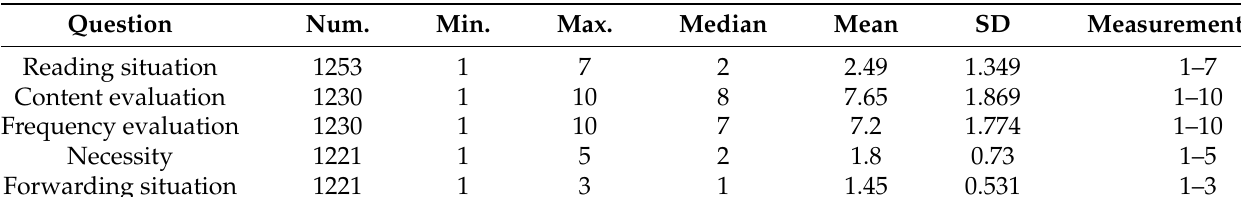
Table 2. Statistics of questionnaire item.